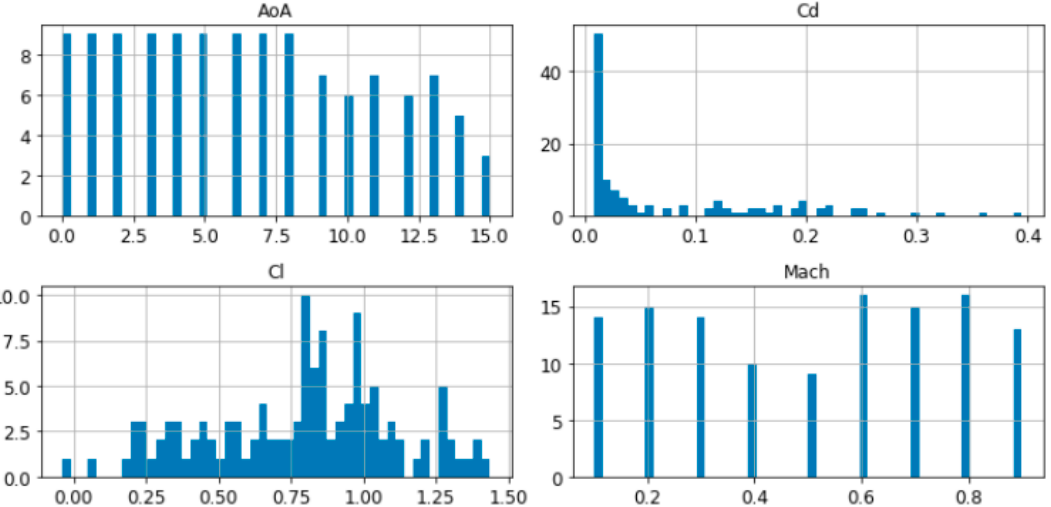
Figure 3. Histograms of the variables in the RAE2822 database (X-axis shows the value of the parameter while Y-axis shows the number of occurrences of that value in the database). Energies 2020 , 13 , x FOR PEER REVIEW